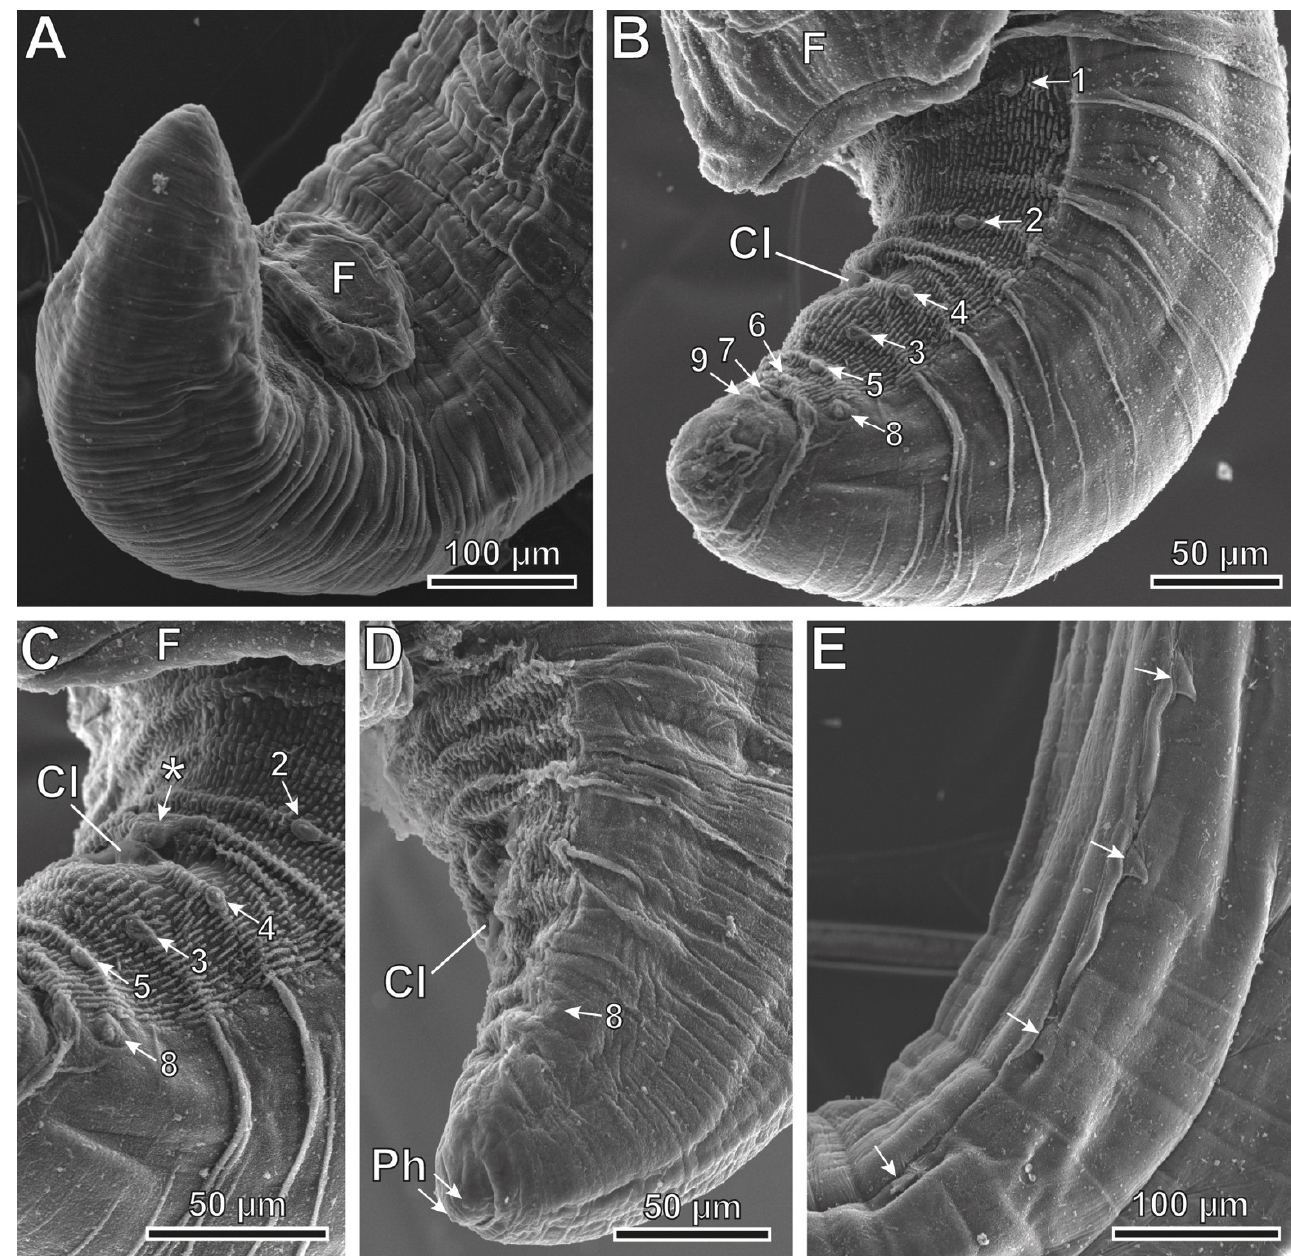
Figure 4. Pterygodermatites ( Pterygodermatites ) plagiostoma male’s caudal extremity, scanning electron microscopy. ( A ) Precloacal position of the midventral fan (F). ( B ) Lateral view showing the distri- bution cloacal papillae (pairs 1–9). ( C ) Cloacal region showing the unpaired precloacal papilla (*). ( D ) Position of phasmids (Ph) near the tail tip. ( E ) Lateral view illustrating the last cuticular spines (arrows). (Cl) Cloaca.